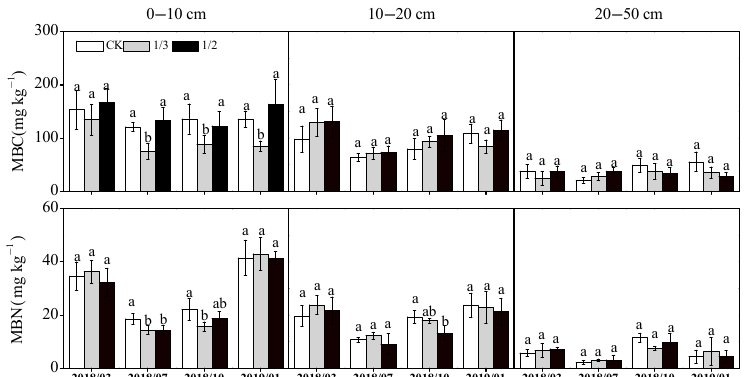
Figure 4. Dynamic changes in soil microbial biomass carbon (MBC) and nitrogen (MBN) in the poplar after pruning treatments. Note: The same lowercase letter over two columns indicates no significant difference between pruning treatments at the same time point ( p > 0.05), while different lowercase letters indicate significant differences between pruning treatments at the same time point ( p < 0.05).